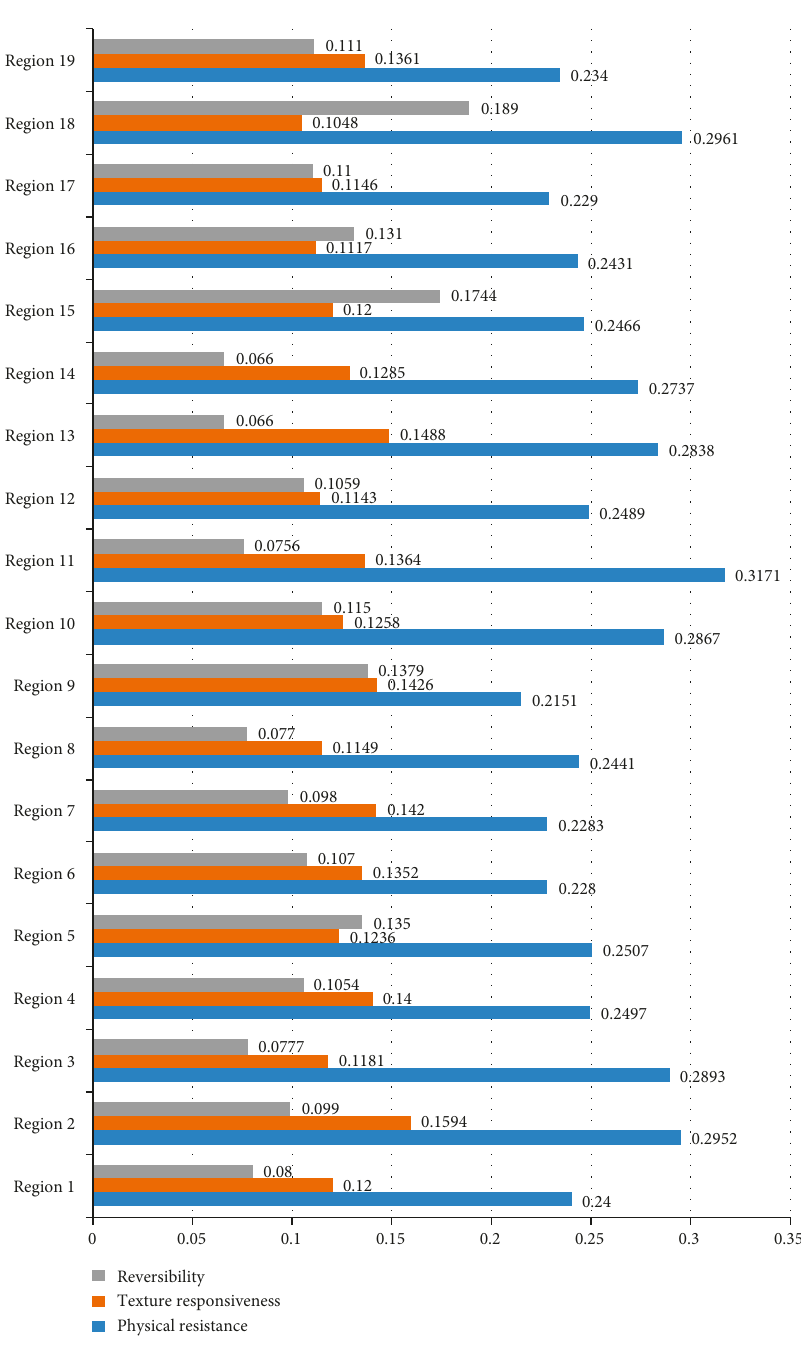
Figure 8: Overall priority of 19 districts of Qazvin city for three main vulnerability